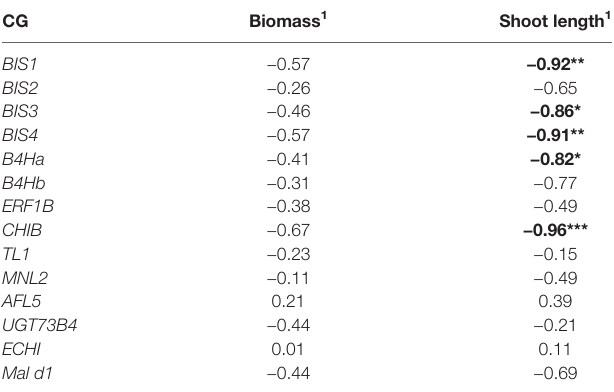
TABLE 3 | Pearson ’ s correlation between the differences in the expression of the 14 candidate genes (CGs, expressed in fold changes) and the differences in fresh biomass and shoot length of plants grown in ARD soil compared to those grown in g ARD soil (biomass/ shoot length in ARD soil - biomass/ shoot length in g ARD soil), signi fi cant correlations are given in bold with p < 0.05 (*), p < 0.01 (**), and p < 0.001 (***).